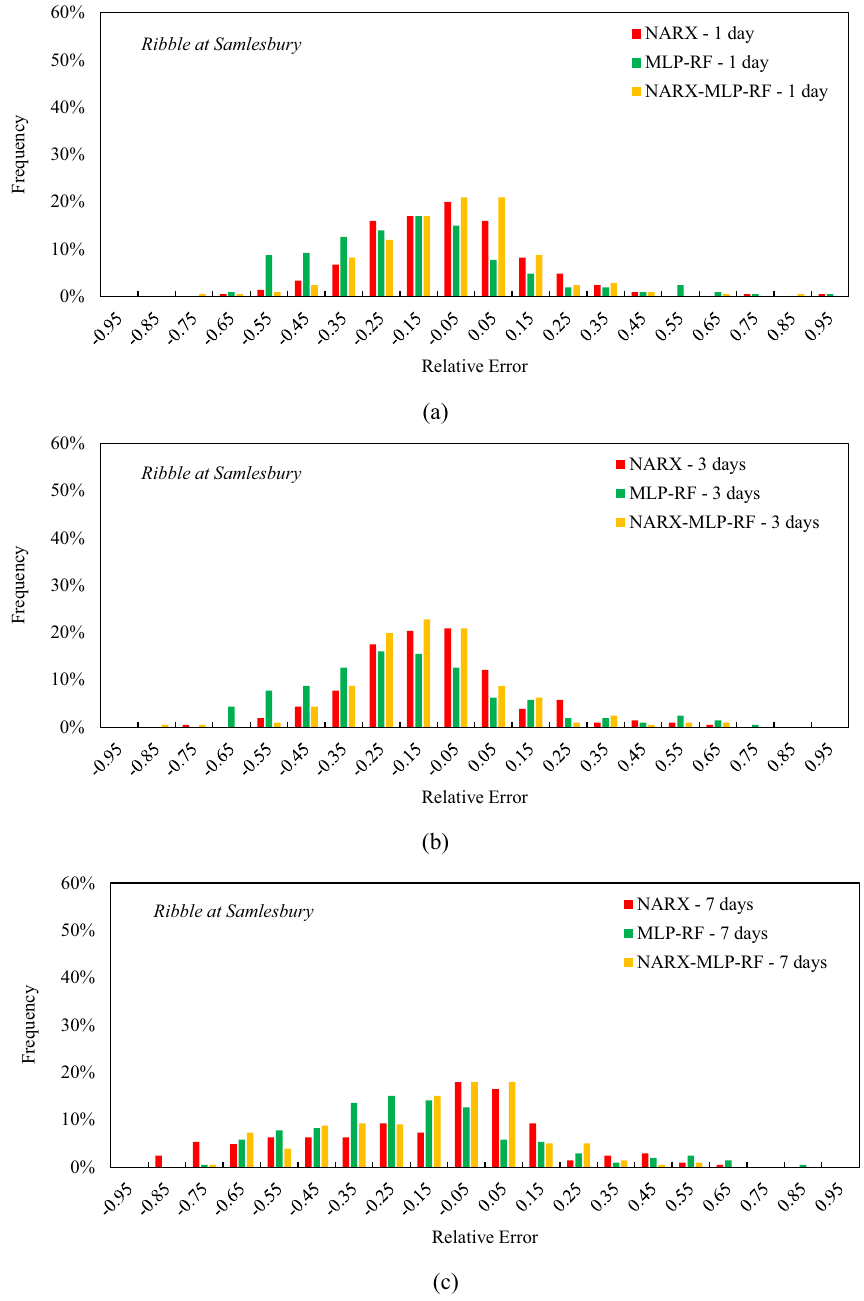
Figure 12. Frequency of the relative error for the tenth decile for Ribble at Samlesbury: t = 1 day ( a ); t = 3 days ( b ); t = 7 days ( c